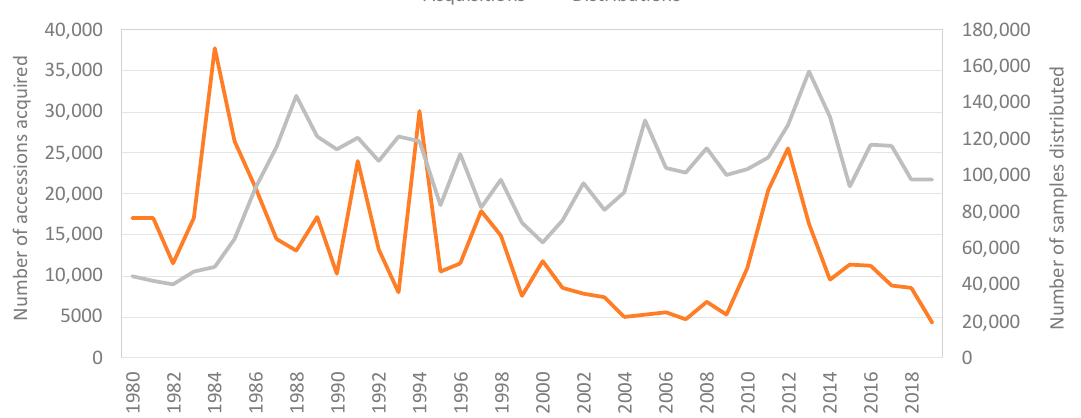
Figure 1. Acquisitions and distributions by all CGIAR Centers 1980–2019 .